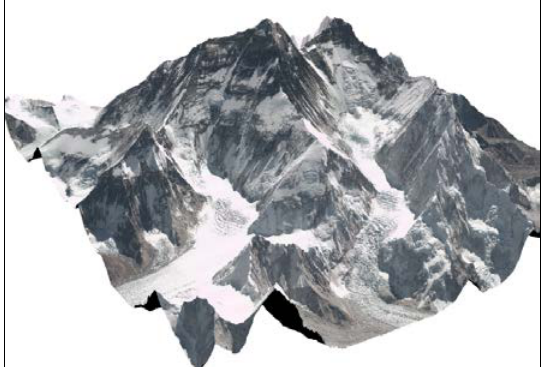
Figure 3: Reconstruction of Mt. Everest in 50 cm/pixel from World View satellite images, provided by